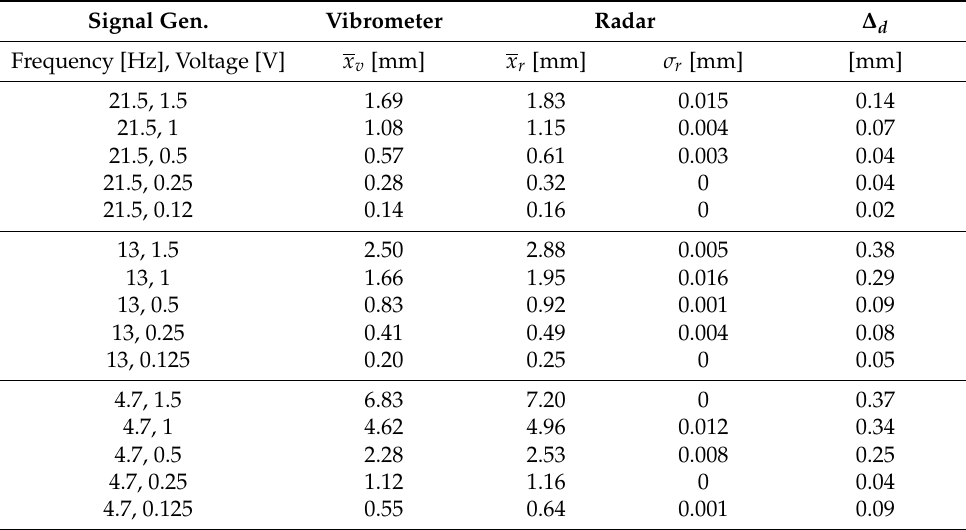
Table 5. Measurement results of the average target displacement obtained in the first setup. The last column reports the difference between the Radar and the vibrometer measurement values. Signal Gen. Vibrometer Radar ∆ d Frequency [Hz], Voltage [V] x v